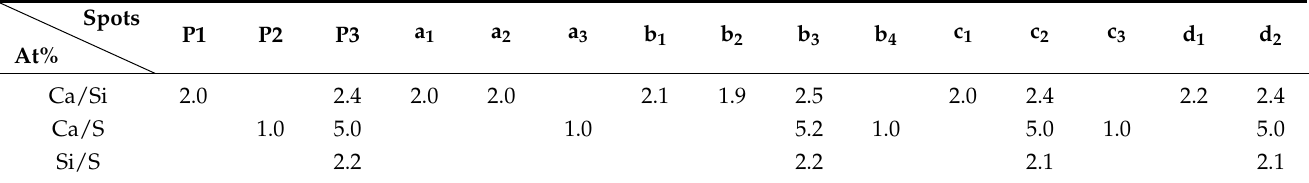
Table 3. EDS spectral results of the marked spots in the image.